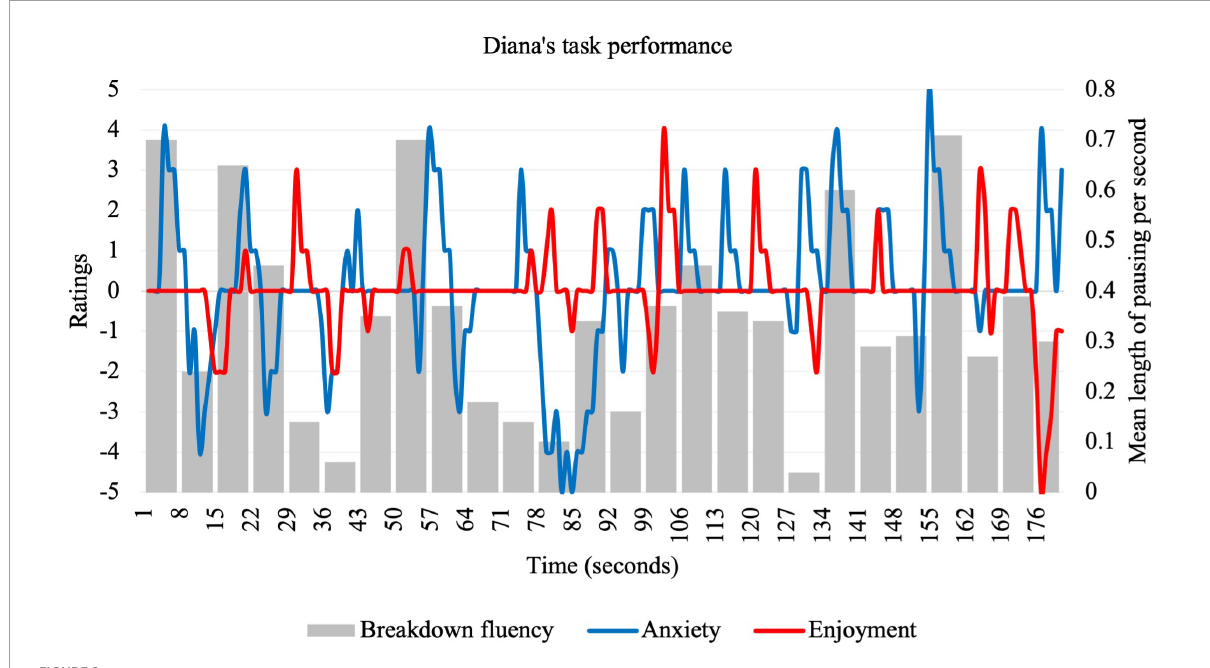
FIGURE2 Idiodynamic ratings and breakdown fluency per segment for Diana’s task